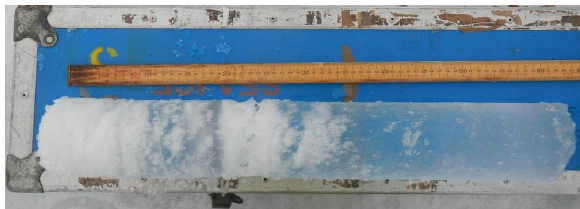
Figure 7. Photo of an ice core extracted from bare ice near the dive hole of the third